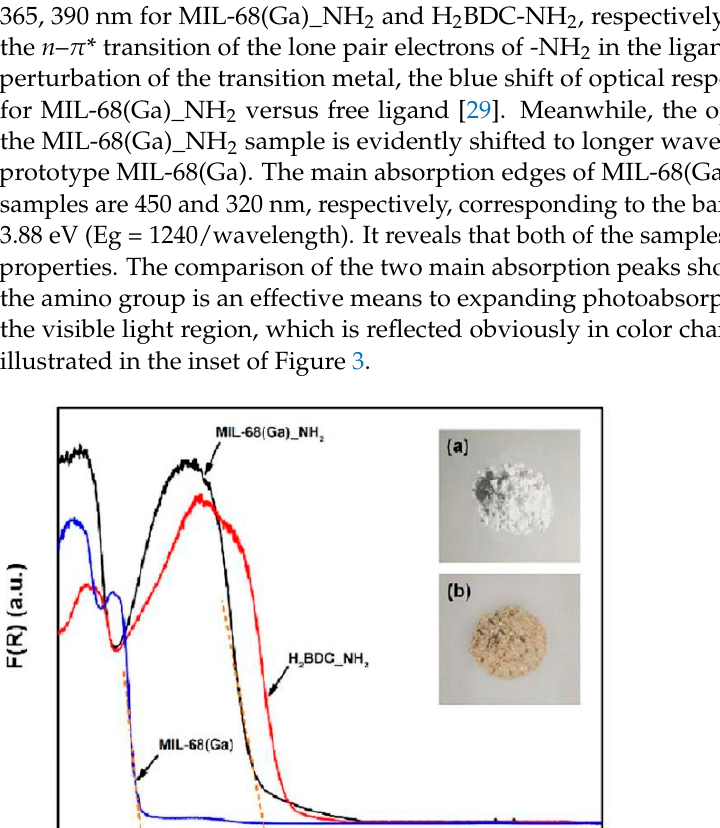
Figure 2. N 2 sorption isotherms of MIL–68(Ga)_NH 2 . (Solid symbols, adsorption; open symbols, de- sorption).